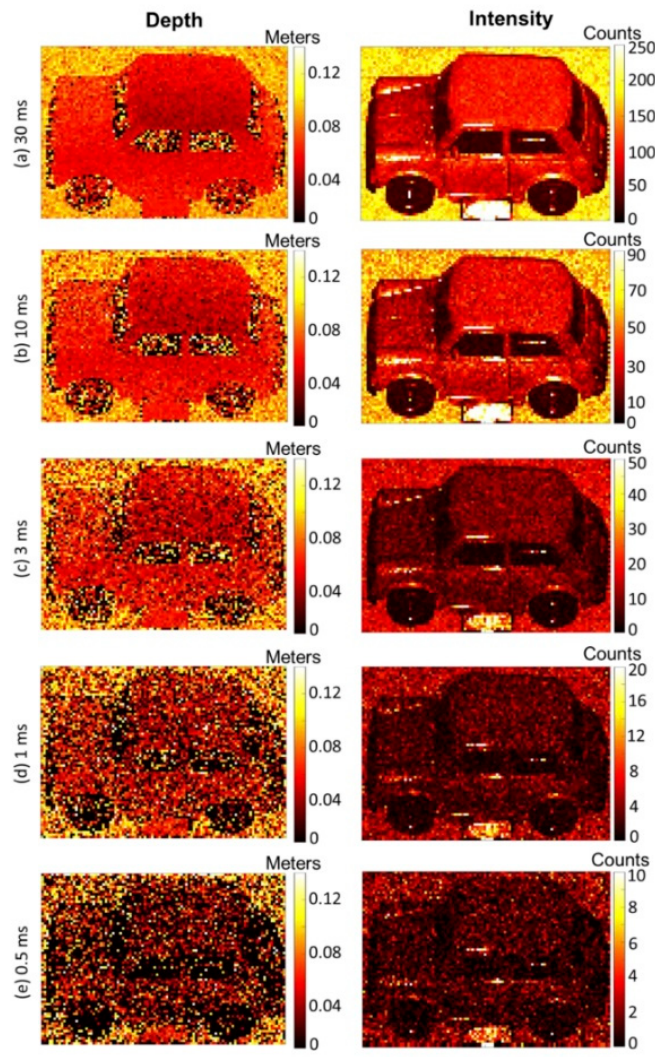
Figure 50. Depth and intensity profile measurements were reconstructed using the pixel-wise cross- correlation approach with the per-pixel acquisition times. Reproduced from [103], Optica Publishing, open access, 2020.